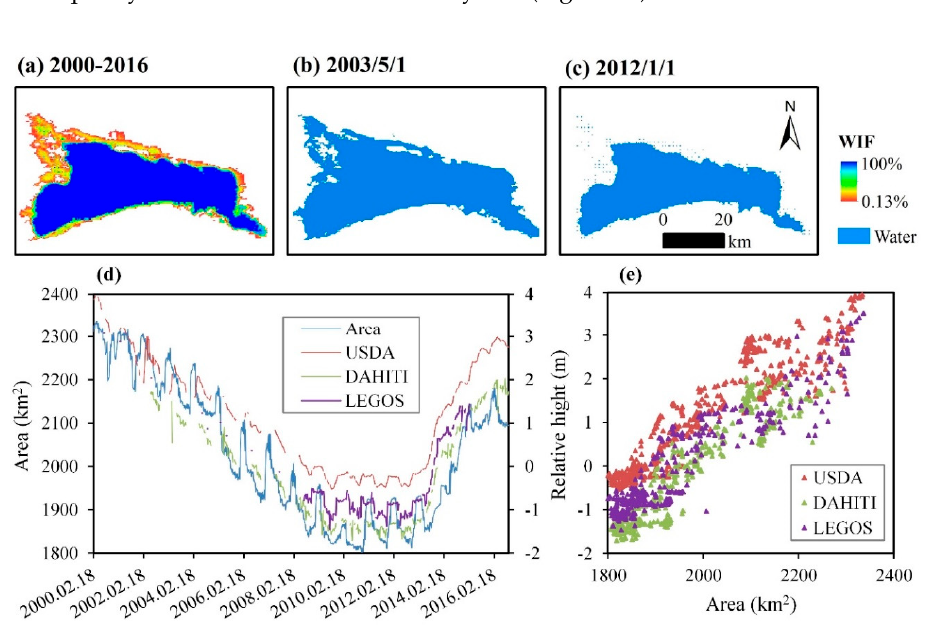
Figure 9. Spatial distribution and temporal variation of Bosten Lake. ( a ) The WIF map in 2000–2016; ( b ) water body map of 2003/5/1, with the largest water area in 2000–2016; ( c ) water body map of 2012/1/1, with the smallest water area in 2000–2016; ( d ) time series of the water area (km 2 ) and relative height (m) in 2000–2016; and ( e ) correlation between water area (km 2 ) and relative height